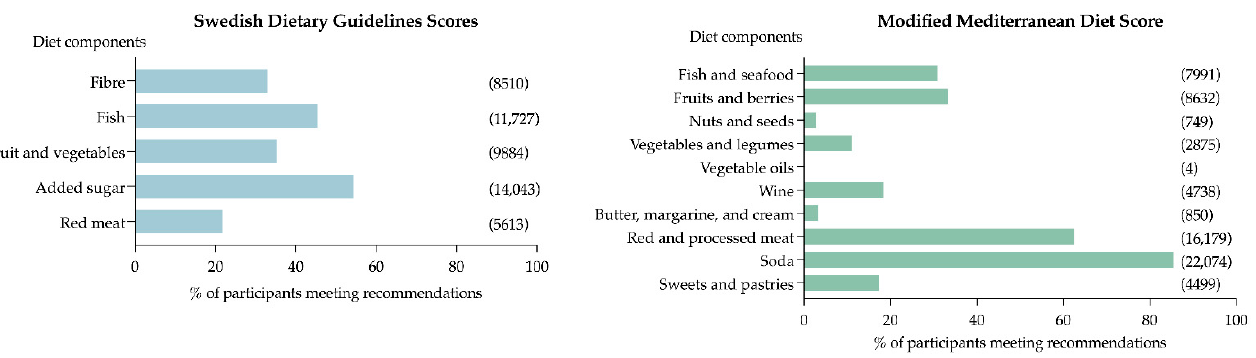
Figure 3. Percentage of participants meeting the recommendations for each diet component. Number of participants meeting recommendations presented in parentheses.